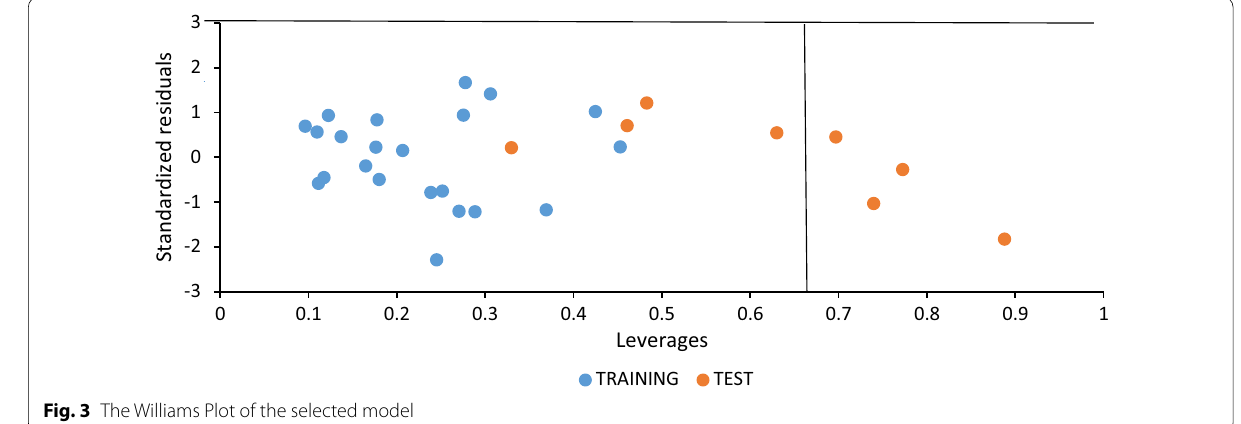
Fig. 3 The Williams Plot of the selected model